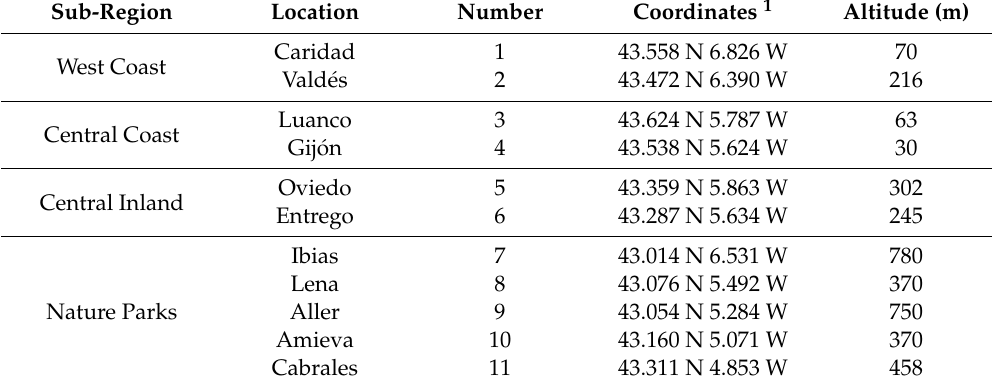
Figure 3. Chosen locations (from different climatic sub-regions of Asturias): west coast ( top left ); central coast ( top right ); central inland area ( central strip ); and nature parks ( bottom ). Table 5. Coordinates and altitudes for the selected locations.